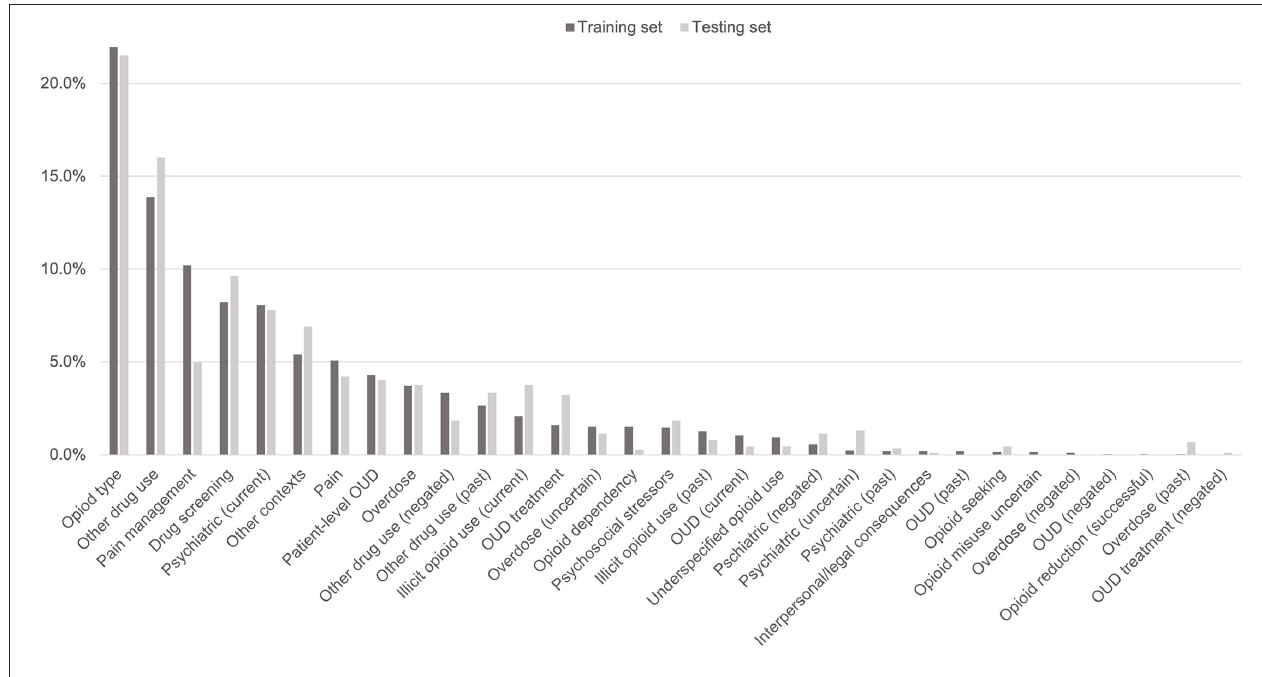
FIGURE 3 | Distribution of classes in testing and training data sets.